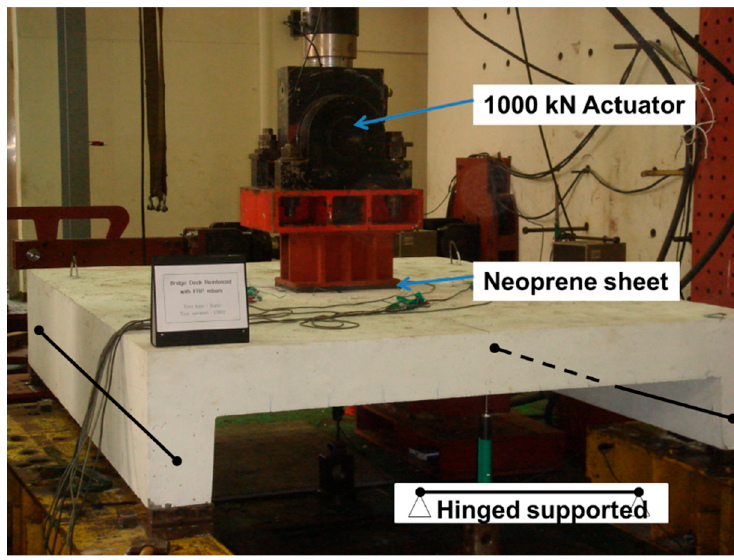
Figure 2. Experimental setup.